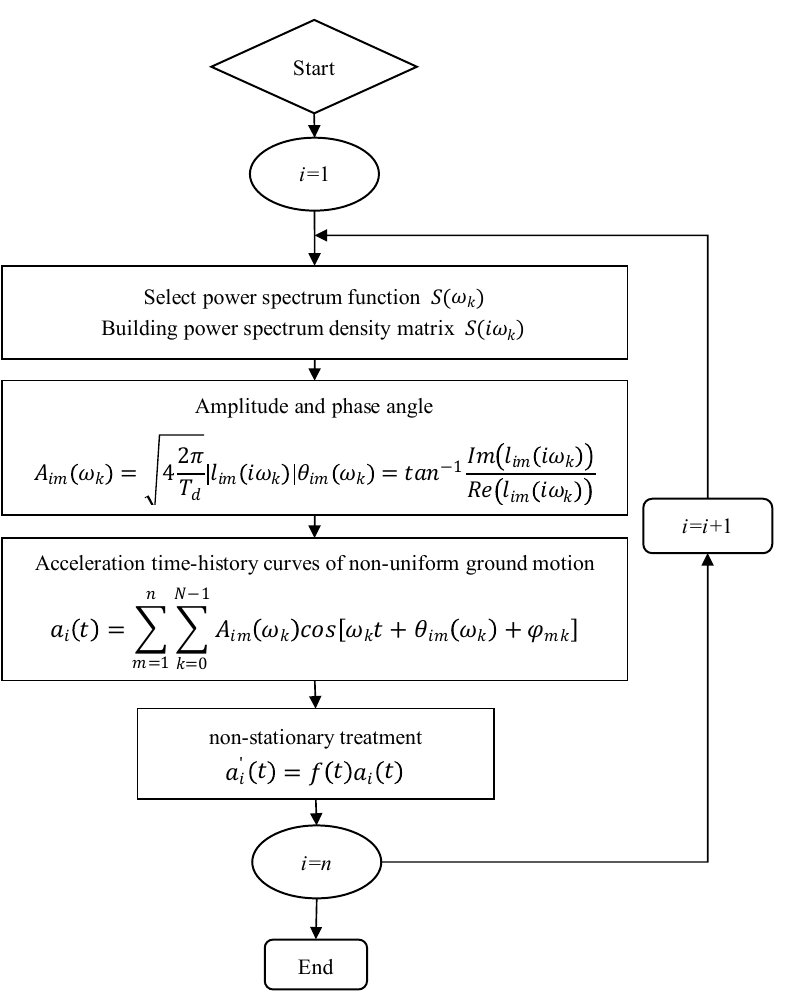
Figure 2. Flow chart of synthesis method for non-uniform ground motion acceleration. The self-power spectrum S ( ω ) in Figure 2 adopts the Kanai Tajimi spectrum, and